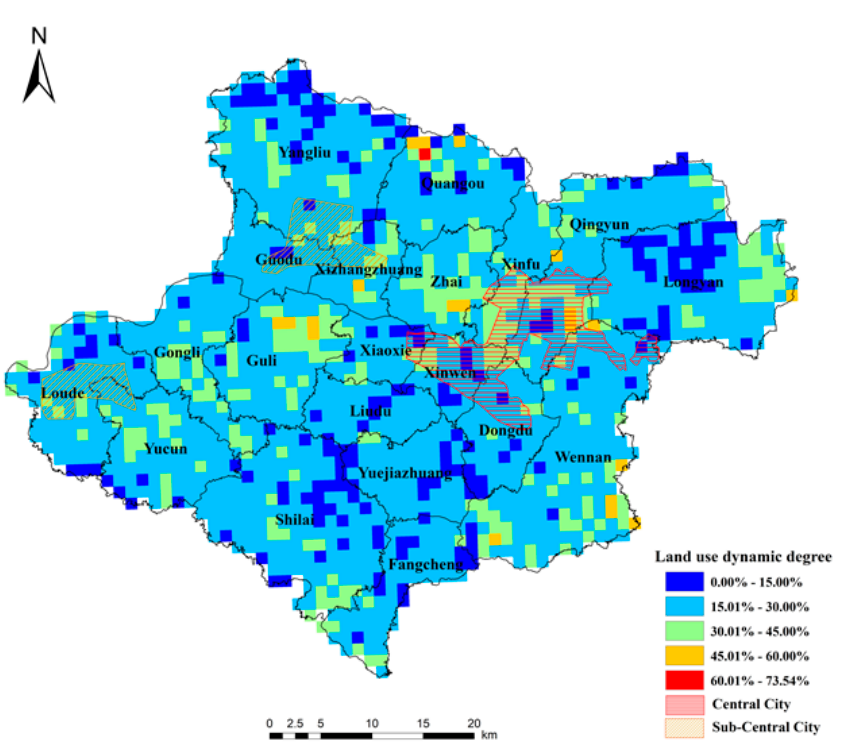
Figure 5. Spatial distribution of the dynamic degree of land use in Xintai from 2009 to 2020.